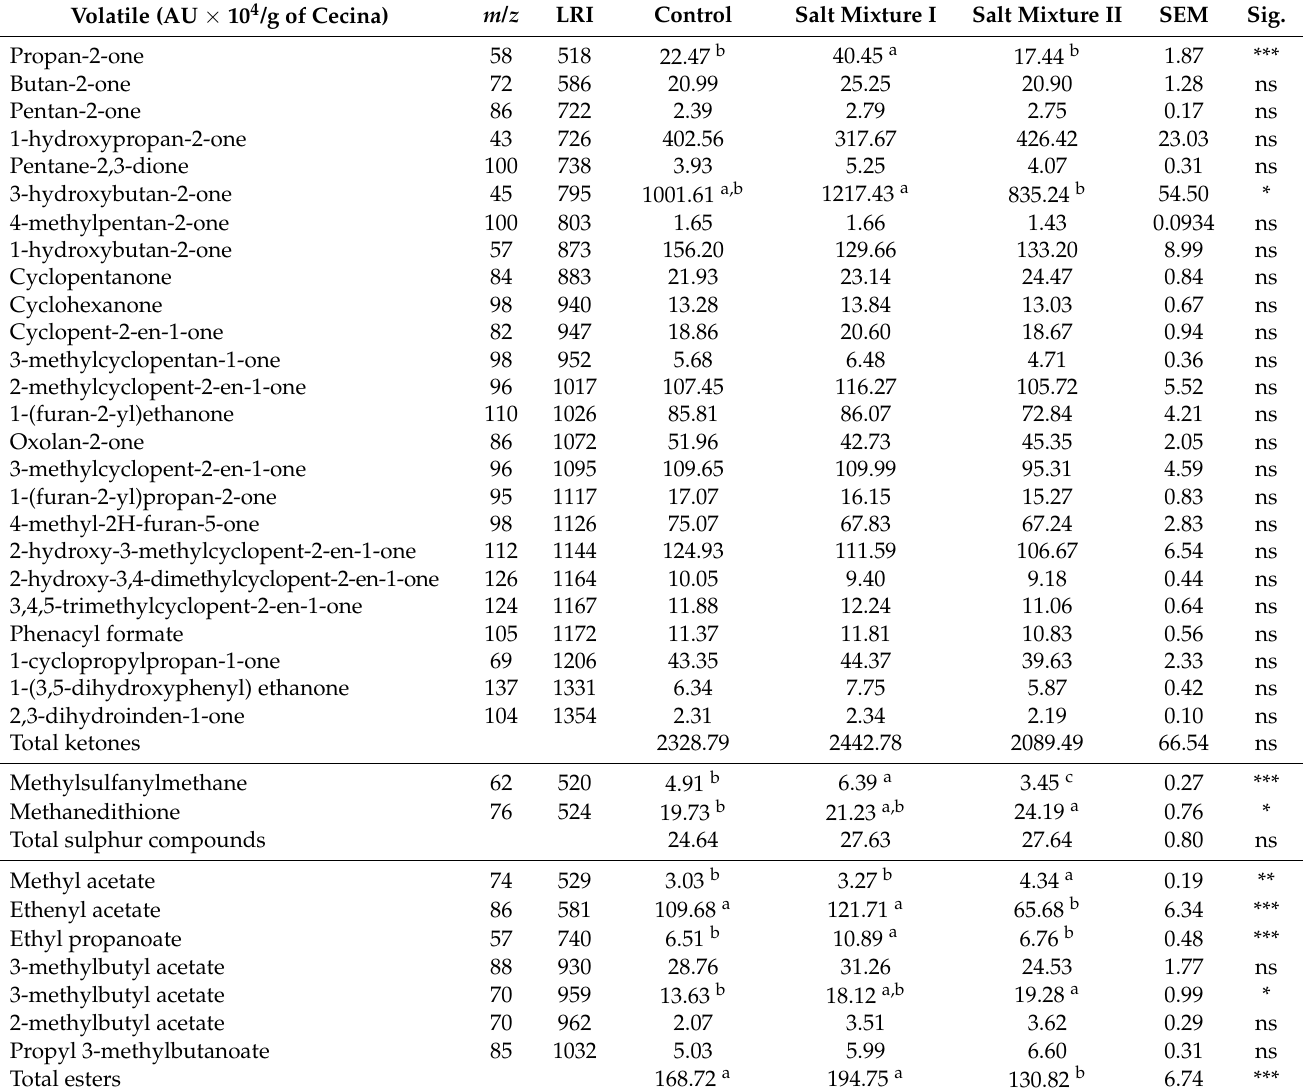
Table 6. Effect of NaCl replacement by other chloride salts on ketones, sulfur compounds, and esters content of dry-cured deer